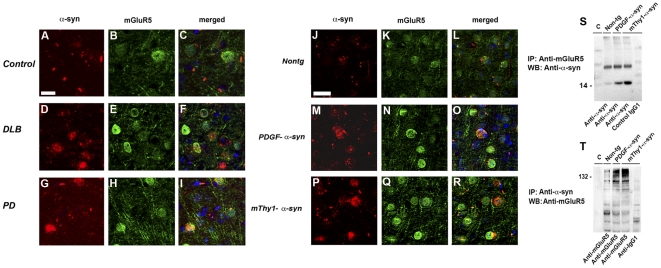
Co-immunoprecipitation and co-localization of alpha-syn and mGluR5.(A, D, G) Representative confocal images of alpha-syn immunolabeling in the frontal cortex of control, DLB and PD cases, respectively. (B, E, H) Representative confocal images of mGluR5 immunolabeling in the frontal cortex of control, DLB and PD cases, respectively. (C, F, I) Co-localization of alpha-syn and mGluR5 immunoreactivity in the frontal cortex of control, DLB and PD cases, respectively. (J, M, P) Representative confocal images of alpha-syn immunolabeling in the frontal cortex of non-tg, PDGF-alpha-syn tg and mThy1-alpha-syn tg mice, respectively. (K, N, Q) Representative confocal images of mGluR5 immunolabeling in the frontal cortex of non-tg, PDGF-alpha-syn tg and mThy1-alpha-syn tg mice, respectively. (L, O, R) Co-localization of alpha-syn and mGluR5 immunoreactivity in the frontal cortex of non-tg, PDGF-alpha-syn tg and mThy1-alpha-syn tg mice, respectively. (S) Representative immunoblot of the co-immunoprecipitation of mGluR5 and alpha-syn using the anti-mGluR5 antibody for the pull-down and the alpha-syn antibody for the detection. (T) Representative immunoblot of the co-immunoprecipitation of mGluR5 and alpha-syn using the alpha-syn antibody for the pull-down and the anti-mGluR5 antibody for the detection. Scale bar  = 20 µM.